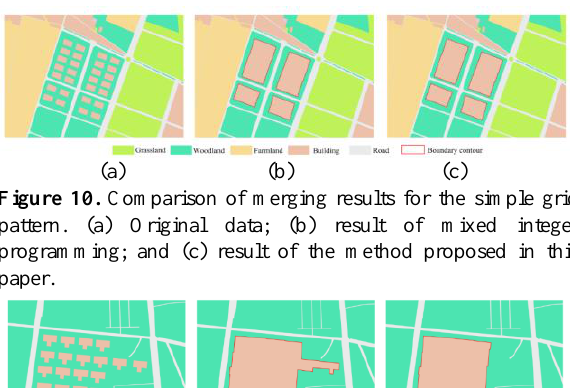
Figure 9. Comparison of merging results for the complex linear pattern. (a) Original data; (b) result of mixed integer programming; (c) result of the method proposed in this paper.